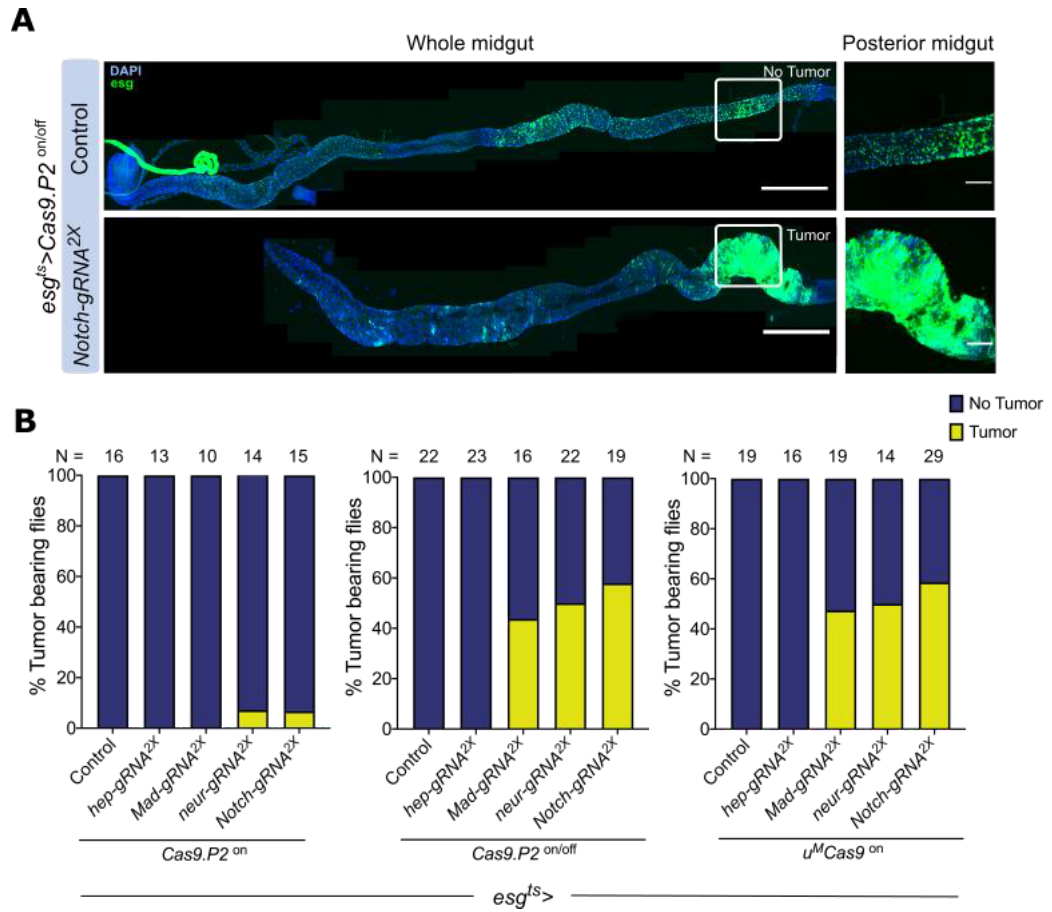
Figure 4. Tumor incidence rate increases after perturbing tumor suppressors. ( A ) Intestinal tumors can be observed after perturbing the Notch pathway; notice the cluster of GFP + cells accumulated in the posterior midgut (insert). ( B ) Quantification of the number of tumor bearing flies after perturbing the BMP, Notch, and JNK pathways. Both Cas9.P2 on/off and u M Cas9 on increase the percentage of tumor bearing flies when gRNAs were used to target Mad , neur , or Notch , while no such effects were seen with Cas9.P2 on . Scale bar: 350 µm, insert — 60 µm.